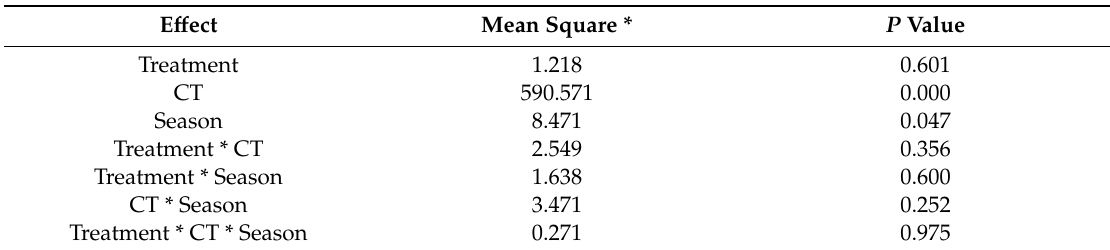
Table 3. ANOVA table comparing the main and interaction e ff ects of treatment (R, F, GAC), CT, and season, on the formation of NDMA in Cork Brook source water. E ff ect Mean Square * P Value